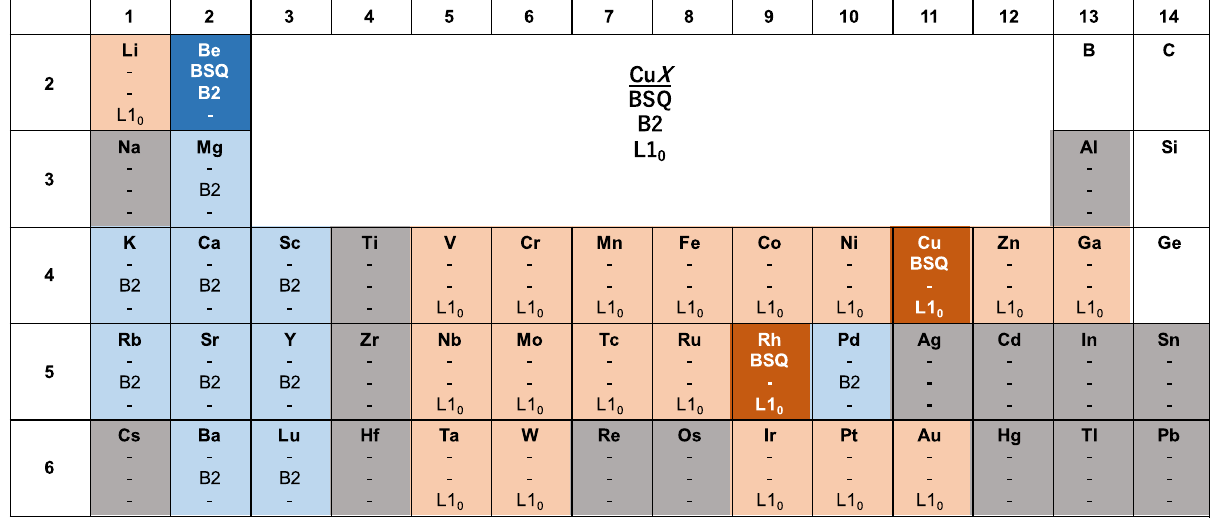
Figure 3. Same as in Fig. 2 but for the Cu X compounds in the BSQ, B2, and L1 0 structures.